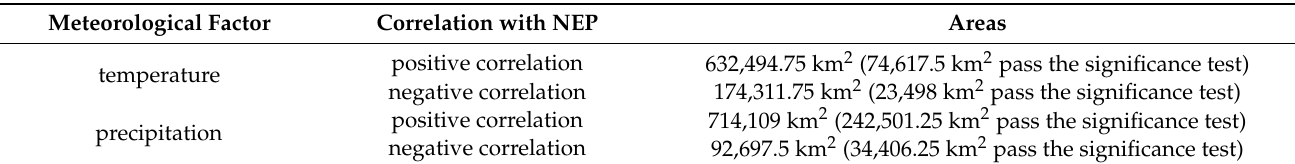
Table 4. Area statistics of correlation between meteorological factors and